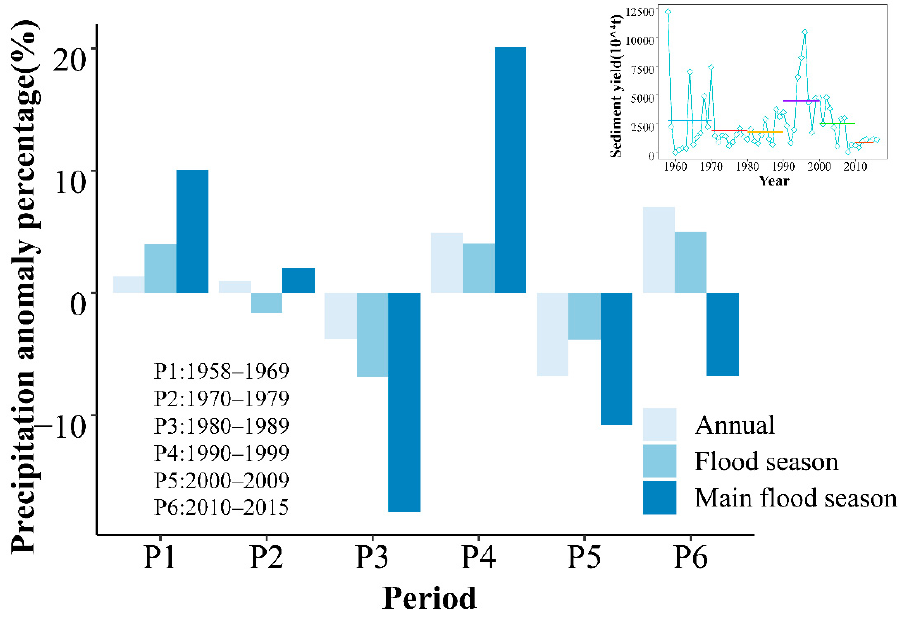
Figure 12. Precipitation anomaly percentage of annual precipitation, flood season precipitation, the main flood season of different periods, and the average annual sediment yield during different periods within the QYS. Right inset: The annual sediment yield in the QYS. (The horizontal line represents the average values during corresponding periods).